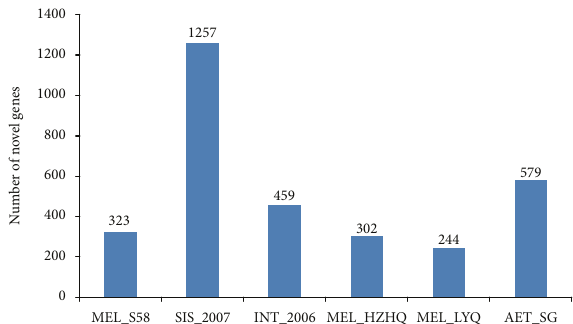
Figure 2: Number of novel transcripts. Histogram of the genes that are not mapped to the current release version of Nakate-Shinkuro reference genome in each of the analyzed